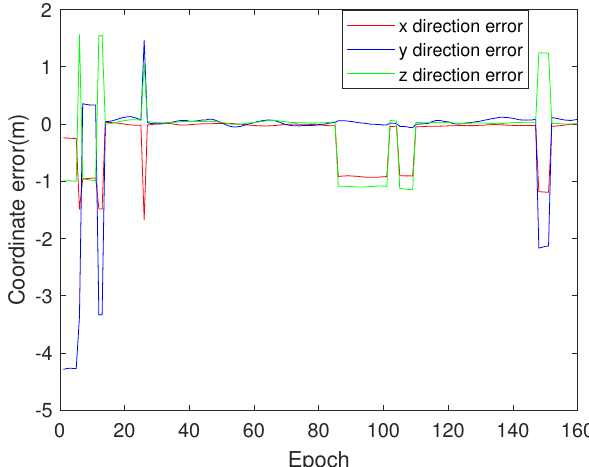
Figure 4. Coordinate identification error with LAMBDA (baseline 2).